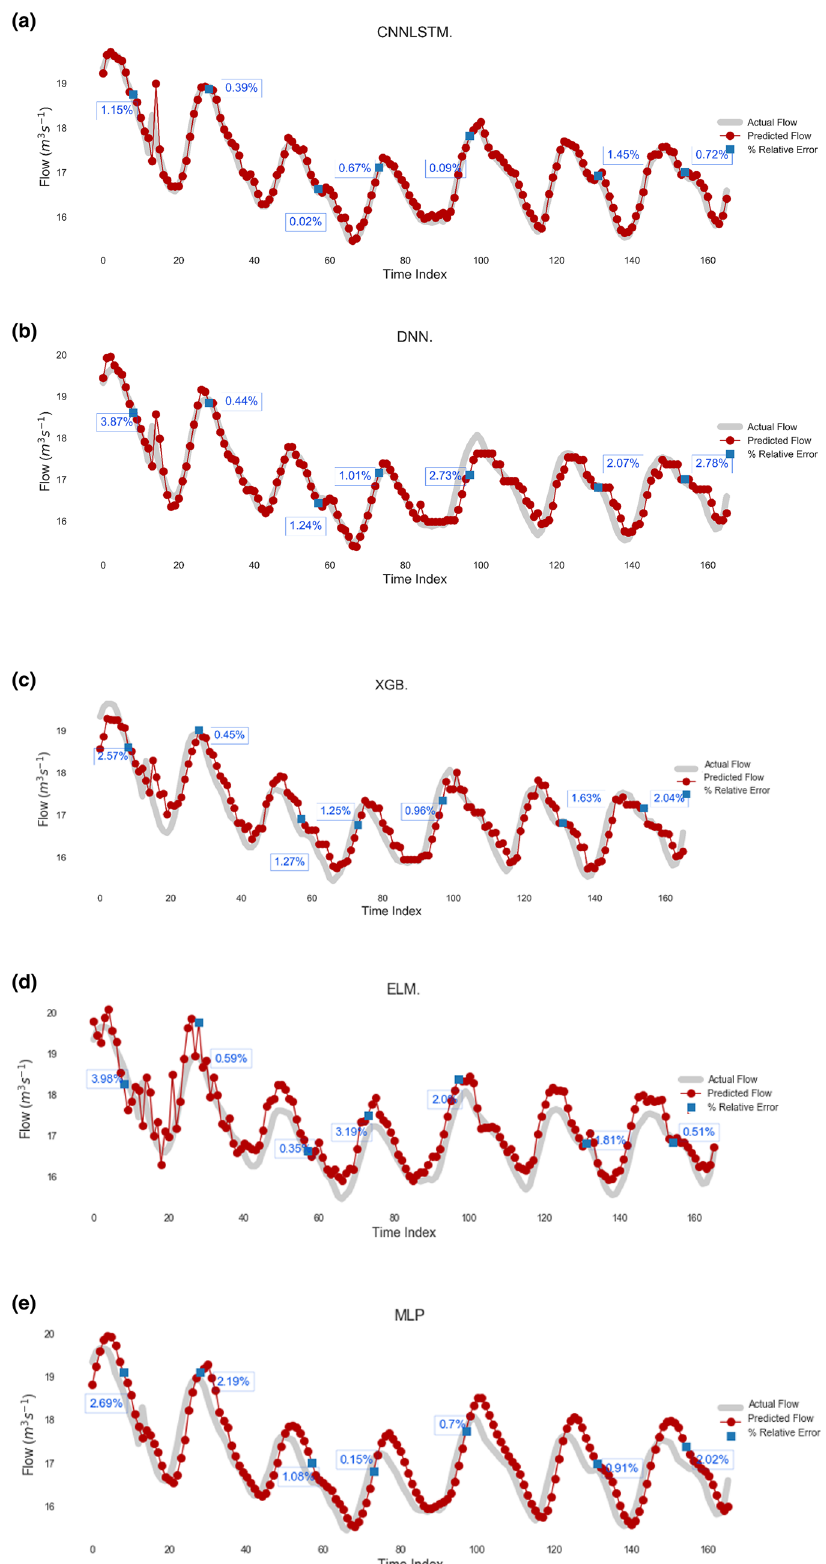
Figure 9. Hydrograph of predicted versus actual streamflow ( Q , m 3 s −1 ) from ( a ) CNN-LSTM model during test period (2-Weeks) compared with standalone model ( b ) Deep Neural Network (DNN), ( c ) Extreme Gradient Boosting Regression Model (XGB) , ( d ) Extreme Learning Machine (ELM) and ( e ) Multi-Layer Perceptron (MLP) for Brisbane River. The relative error are shown in blue